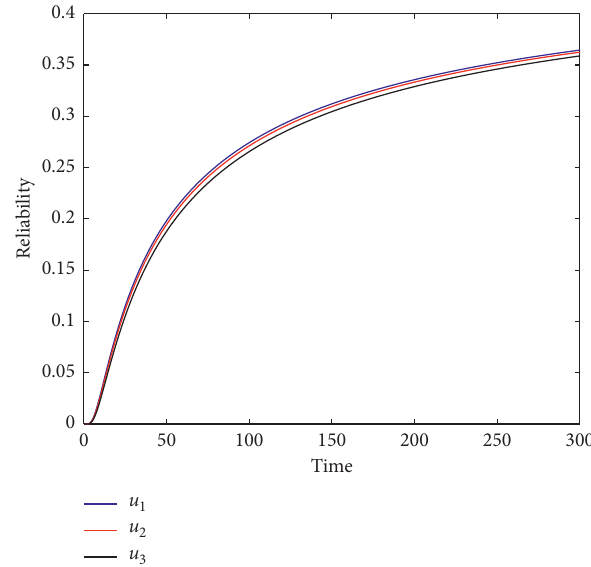
Figure 3: The PDF of achieving social trust for system (2) with initial conditions given in Example 2.